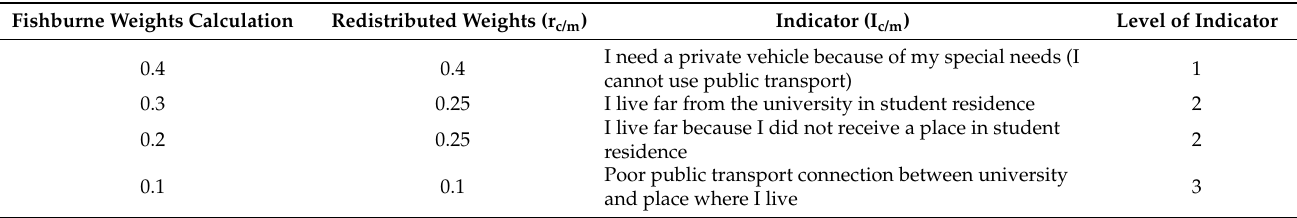
Table 26. Reasoning indicators for private car/motorcycle.